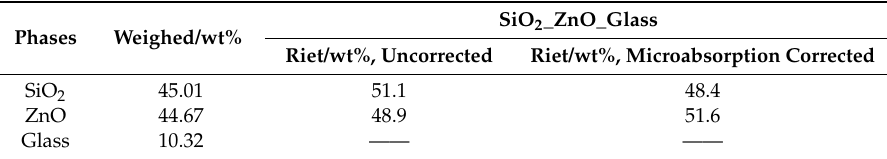
Figure 1. Rietveld XRD pattern of an artificial mixture (The circles correspond to observed data, the thin line is the calculated patterns by the Rietveld method. The Yobs-Ycal stands for the difference pattern plotted as blue line at the bottom). Main peaks due to each phase have been labeled Δ :SiO 2 ; Θ :ZnO. Table 2. Rietveld Quantitative Phase Analysis of the Mixture.